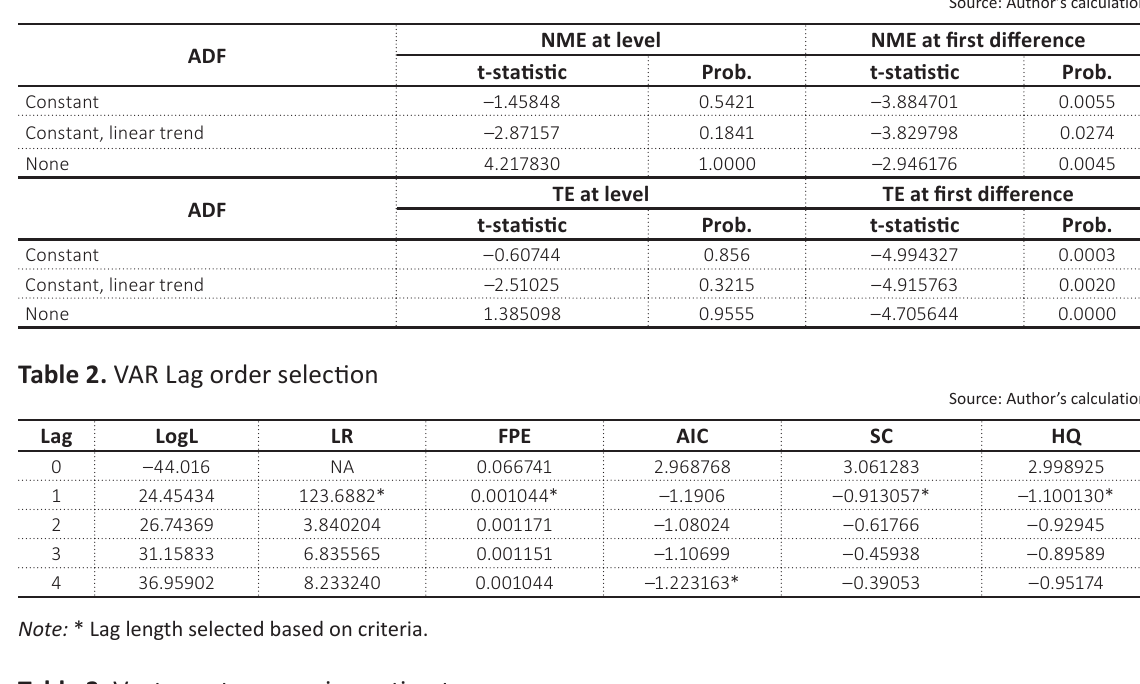
Table 1. Augmented Dickey-Fuller tests